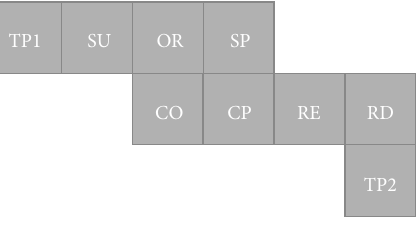
Figure 8: Modified layout.